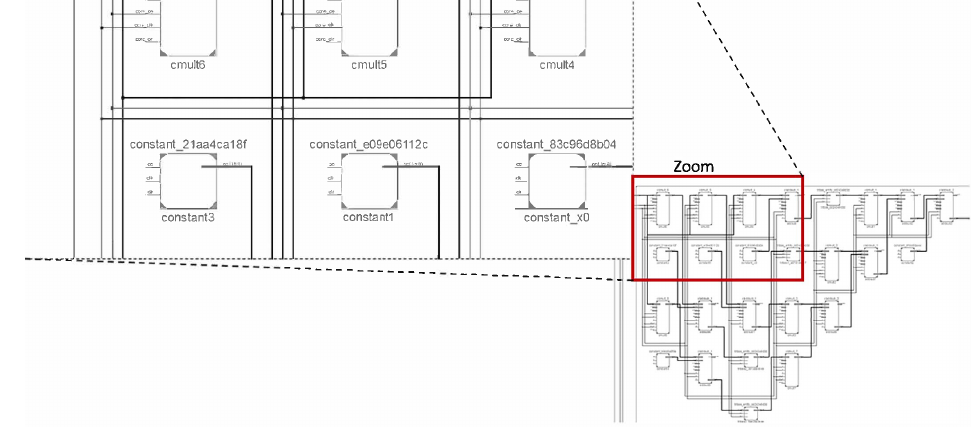
Figure 9. A zoom on NN AM/AM entity.